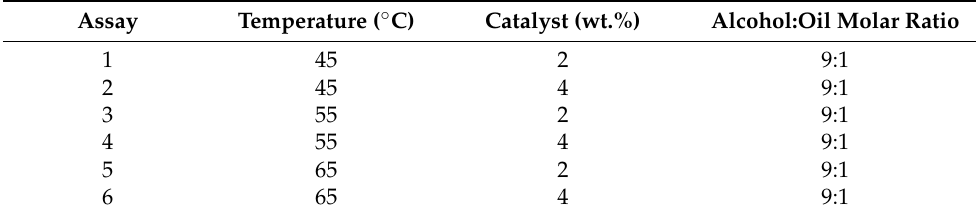
Table 1. Experimental conditions for homogenous acid esterification.